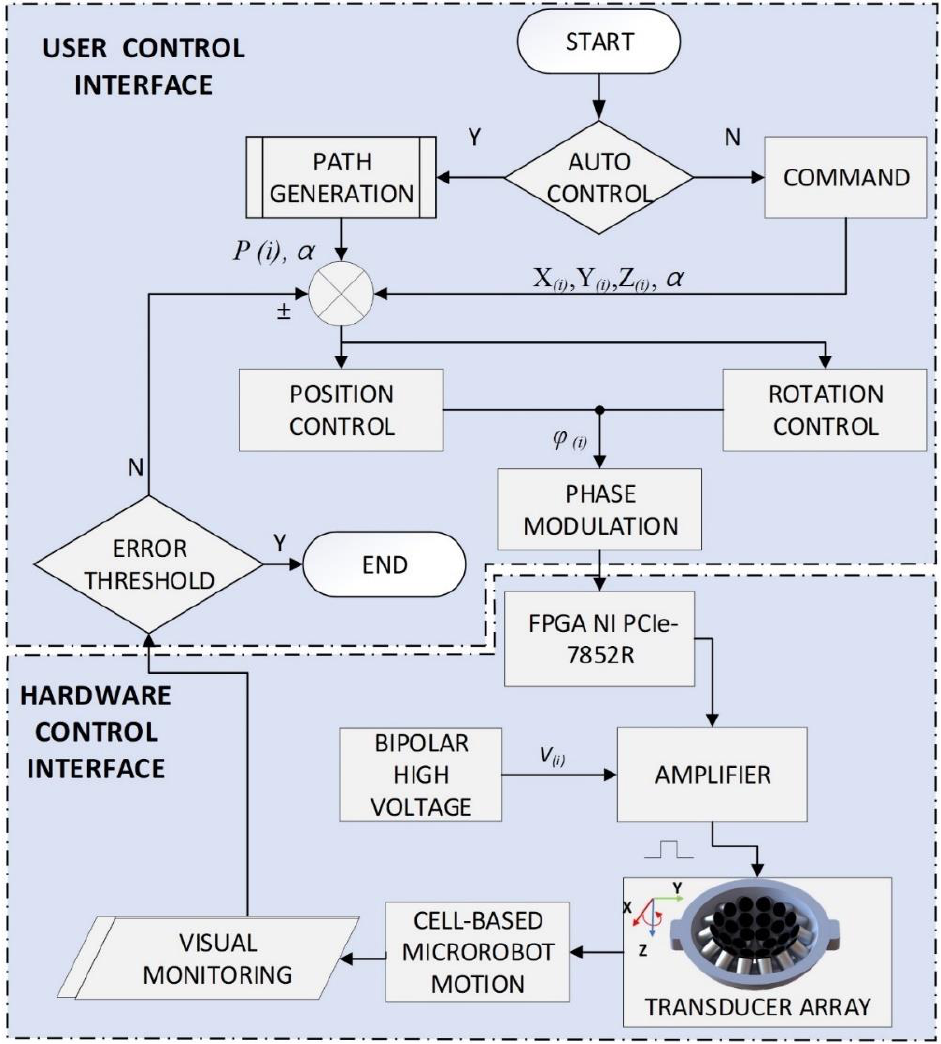
Figure 2. Close-loop control block diagram for acoustically driven Macbots experiment.